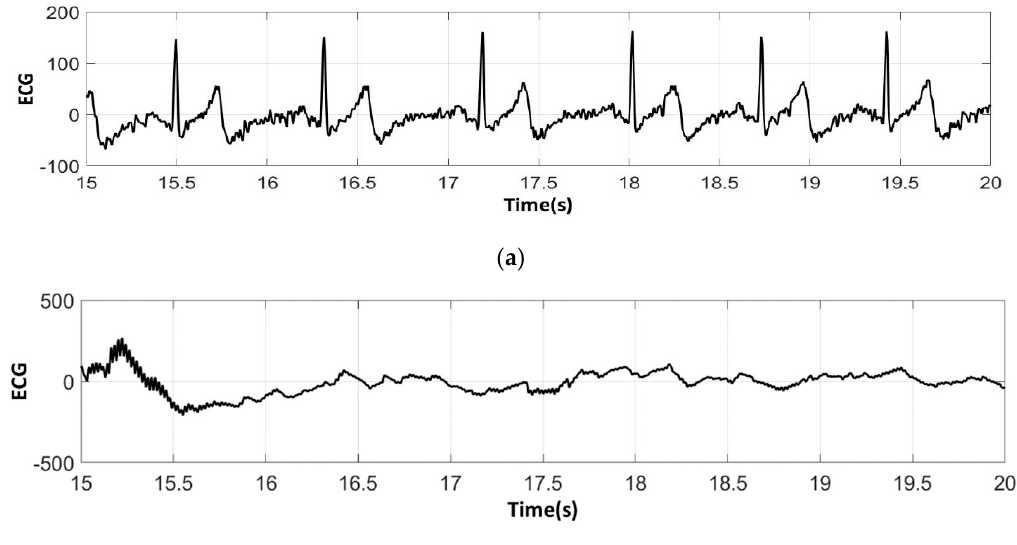
Figure 15. ECG signal obtained by 100% cotton electrodes with 7.4 wt.% PEDOT:PSS: ( a ) before washing; ( b ) after 50 washing cycles.